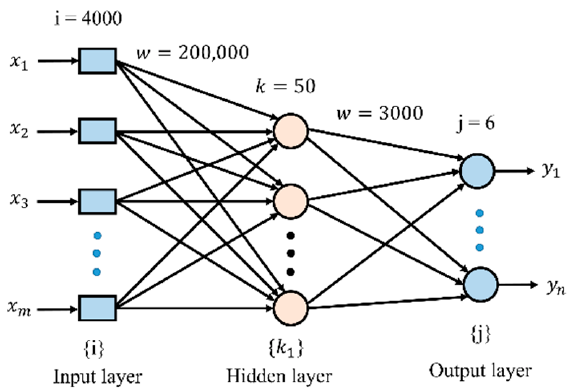
algorithm transforming the set of signal samples into a set of spectral density coefficients